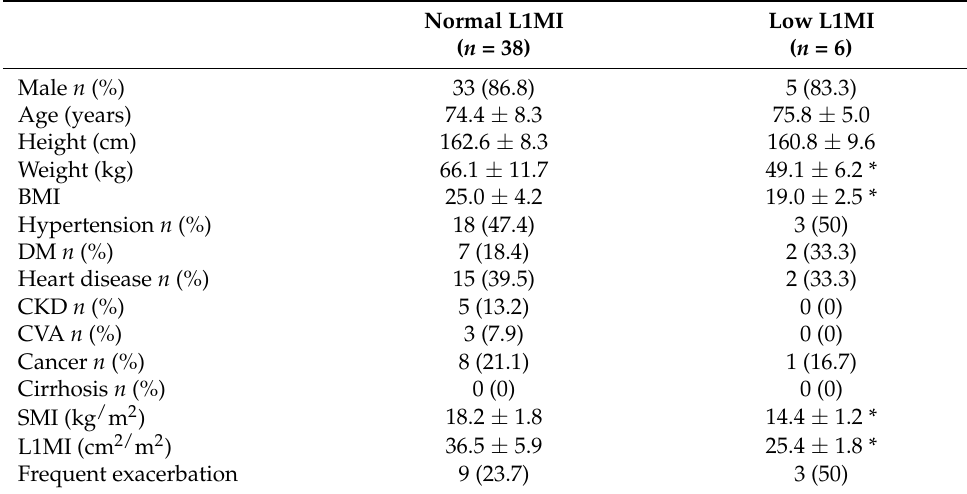
Table 3. The clinical characteristics of COPD patients with low and normal L1MI.